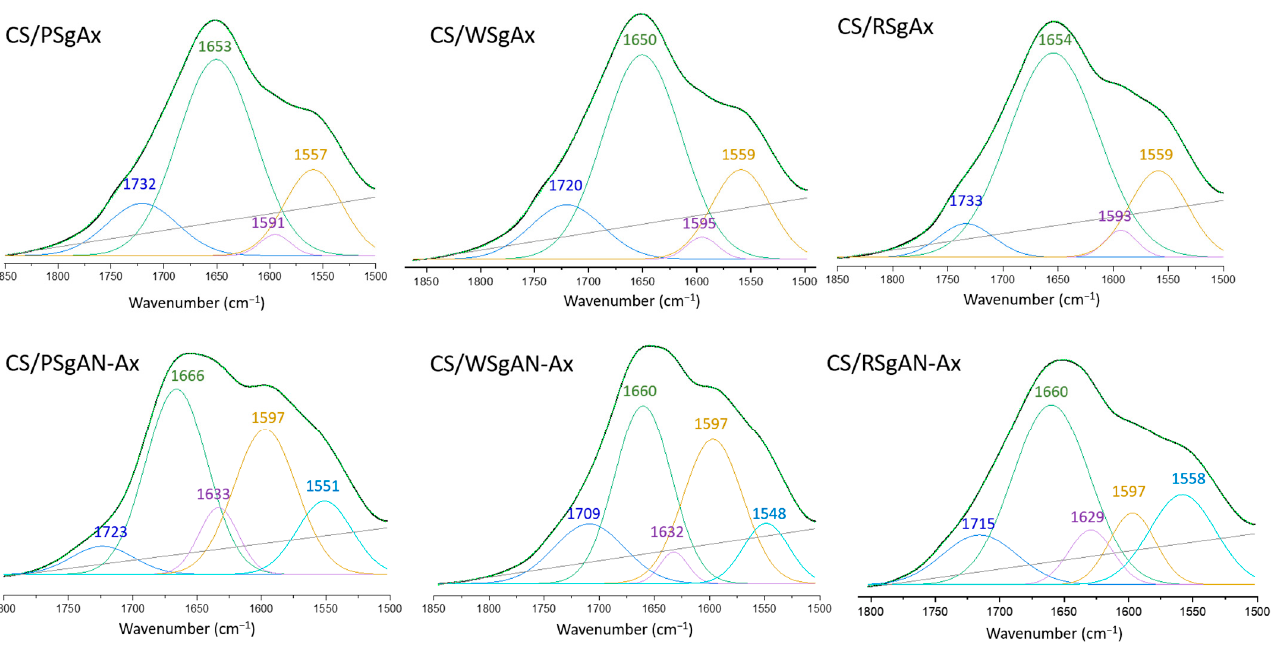
Figure 5. Deconvolution of 1800–1500 cm − 1 region of FTIR spectra of CS/amidoximated starch beads obtained by the two procedures.